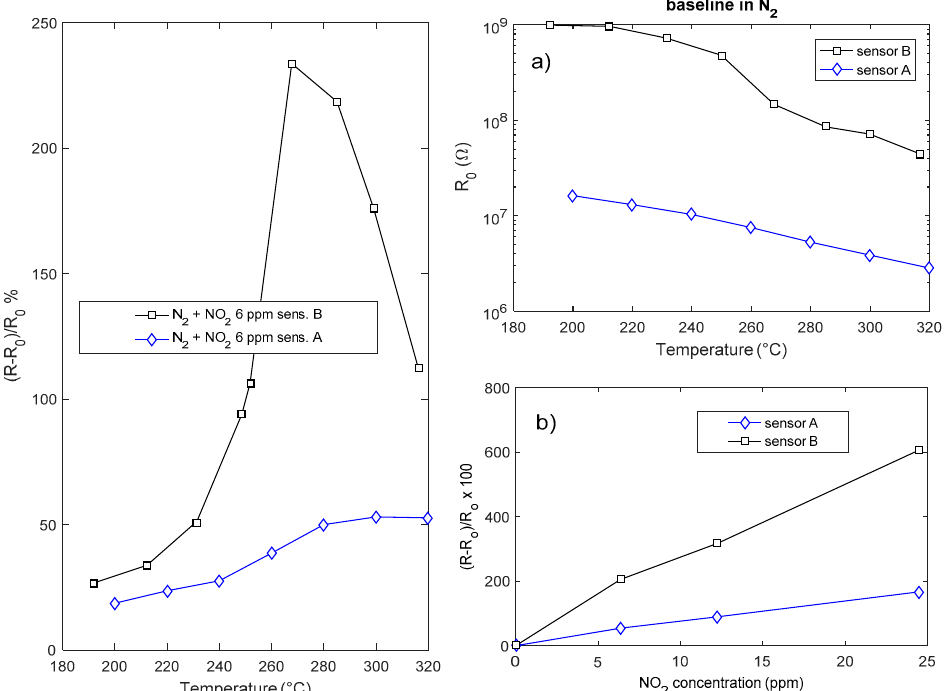
Figure 11. Gas sensing properties of two In 2 O 3 sensors (sensor A-deposition time 4 h, sensor B-deposition time 2 h). Leftmost plot: response as a function of temperature to NO 2 . Rightmost plots: ( a ) Baseline resistance in air as a function of temperature. ( b ) Response to NO 2 as a function of NO 2 concentration at 300 °C.